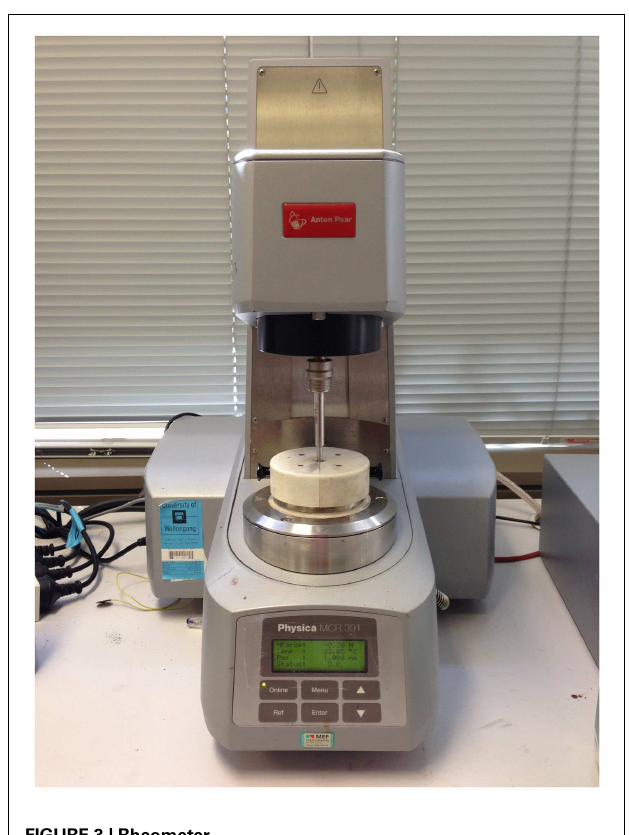
FIGURE 3 | Rheometer .